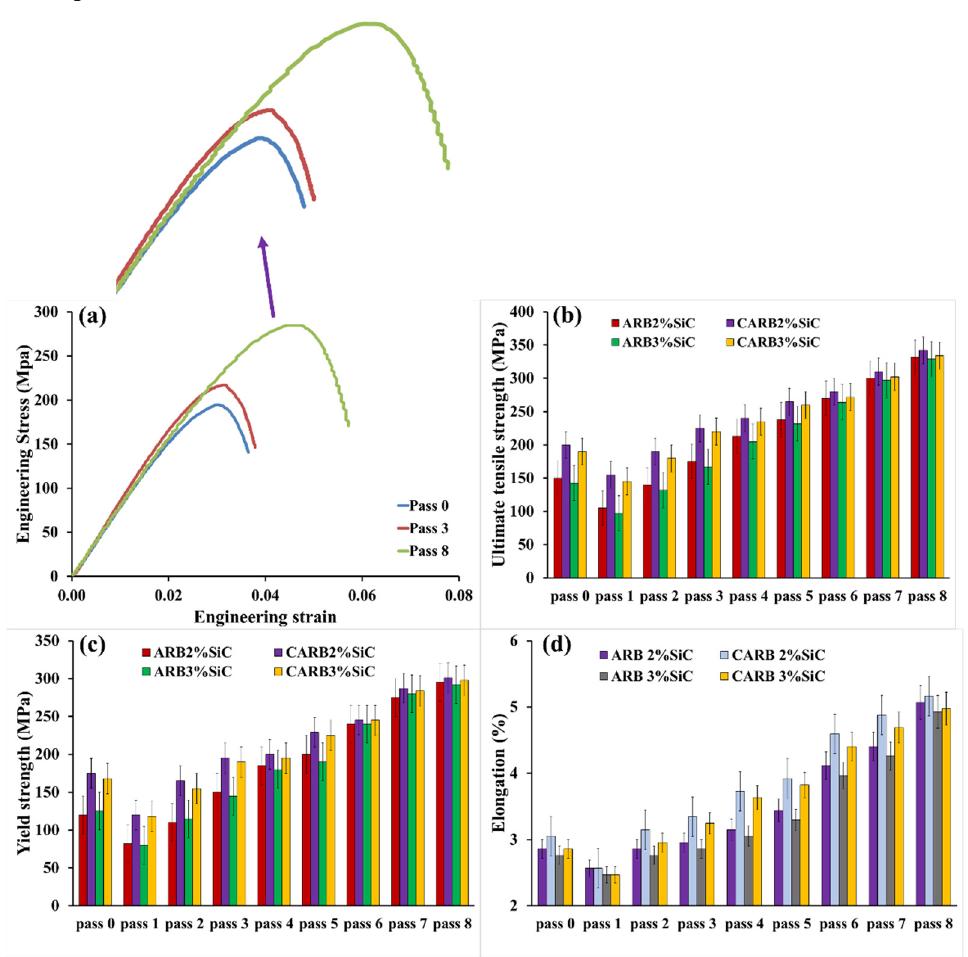
Figure 9. Mechanical properties of composites at different passes: ( a ) stress–strain curves of CARBed Al/Cu/2wt%SiC, ( b ) ultimate tensile strength and ( c ) yield strength, ( d ) elongation. Al/Cu/2wt%SiC, ( b ) ultimate tensile strength and ( c ) yield strength, ( d )